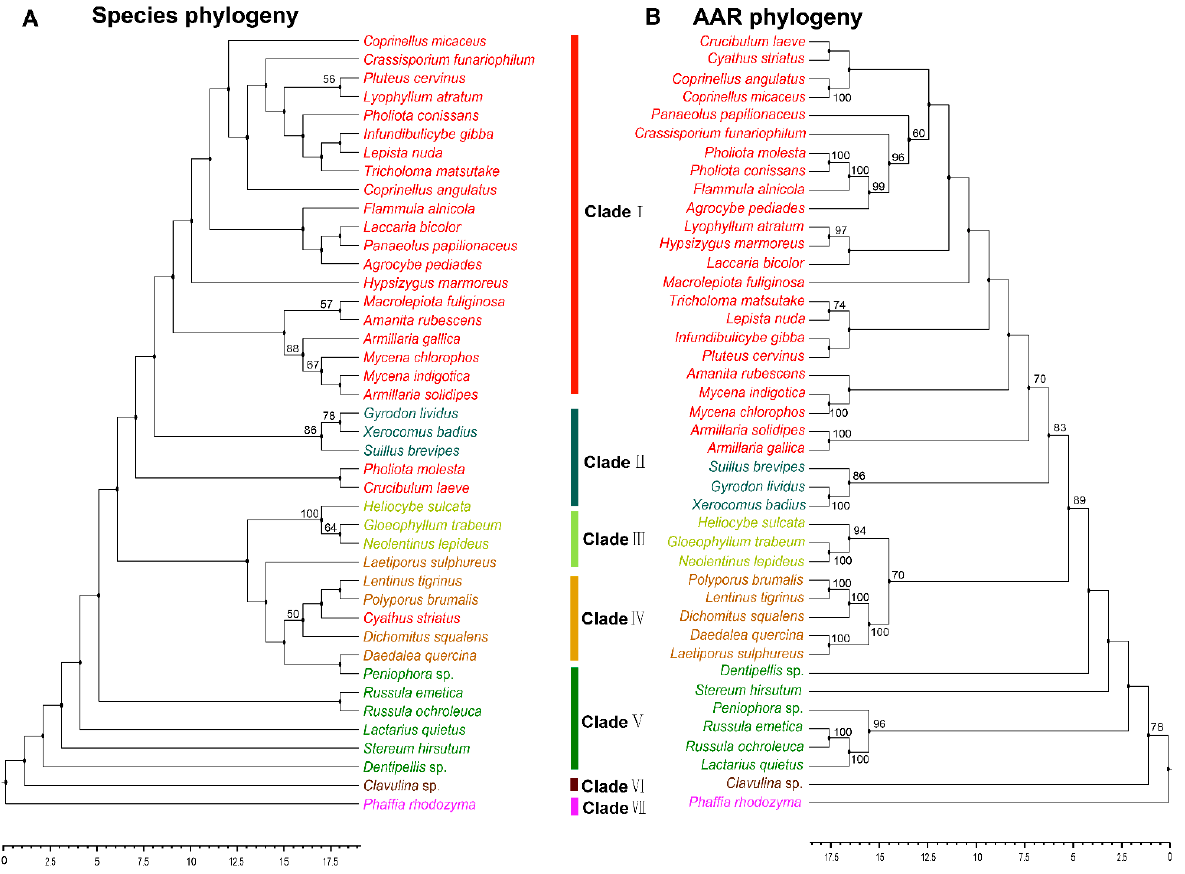
Figure 3. Phylogenetic relationship both species and AAR homologous sequences in Agaricomy ‐ cetes. ( A ) Maximum likelihood tree showing the relationships among different orders of Agaricomycetes based on LSU, SSU, RPB1, RPB2, ITS (5.8 S), and EF1- α genes with species in Tremellomycetes as the outgroup. ( B ) Maximum likelihood tree showing the relationships among different orders of Agaricomycetes based on AAR amino acid sequence with species in Tremellomycetes as outgroup. MP bootstrap values ( ≥ 50%) of each clade are indicated at nodes. Scale bar in the upper left indicates substitutions per site (Clade I: Agaricales, Clade II: Boletales, Clade III: Gloeophyllales, Clade IV: Polyporales, Clade V: Russulales, Clade VI: Cantharellals, and Clade VII: Tremellomy ‐ cetes).